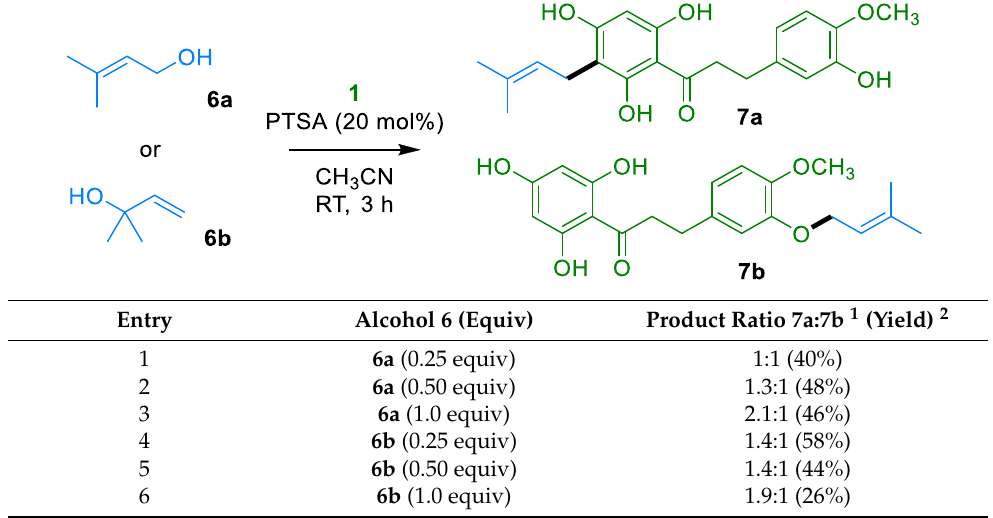
Table 3. Catalytic Prenylation of Dihydrochalcone 1